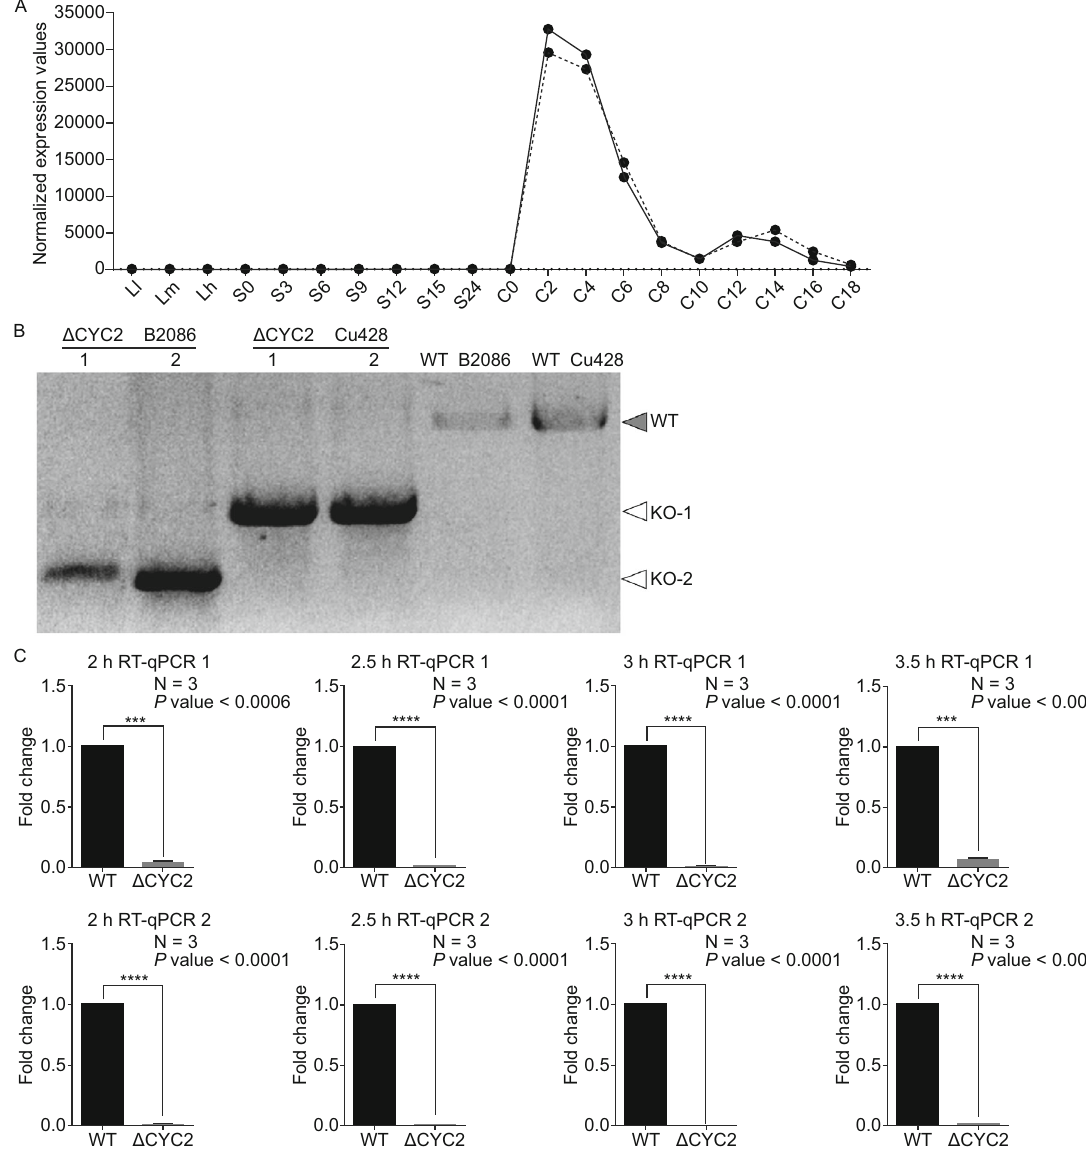
Figure 1. Transcriptional expression pro fi le of CYC2 (TTHERM_00079530) in T . thermophila and con fi rmation of CYC2 knock- out strains . (A) The line chart was generated with microarray data of mRNA products of all time points (three GROWTH time points, seven STARVATION time points and ten conjugation time points) in life cycle of T. thermophila . The solid and dashed lines denoted the expression values normalized by two different methods. For vegetatively growing cells, L-l, L-m, and L-h respectively correspond to ∼ 1 × 10 5 cells/mL, ∼ 3.5 × 10 5 cells/mL, and ∼ 1 × 10 6 cells/mL. Samples collected at 0, 3, 6, 9, 12, 15, and 24 h after starvation began were respectively referred to as S-0, S-3, S-6, S-9, S-12, S-15, and S-24, and at 0, 2, 4, 6, 8, 10, 12, 14, 16, and 18 h after mixing equal volumes of B2086 and CU428 cells for conjugation initiation referred to as C-0, C-2, C-4, C-6, C-8, C-10, C-12, C-14, C-16, and C-18. It is manifested that CYC2 expressed at transcriptional level exclusively during conjugation and abundantly during 2 – 4 h after conjugation initiation followed by additional expression around 12 – 14 h. (B) The CYC2 knock-out strains ( Δ CYC2 ) of two different mating types (B2086 and Cu428) were con fi rmed by whole cell extract PCR. The difference of PCR products lengths between strains of two mating types (marked as KO-1 and KO-2) was reasonable for a deleted region larger than target sequence, and it was often observed during the process of co-deletion (Hayashi and Mochizuki, 2015). (C) The fold changes of mRNA expression level of paired strains of Δ CYC2 at 4 time points after conjugation initiation were examined by RT-qPCR using two different primer sets in CDS ( ‘ qPCR mRNA check-1